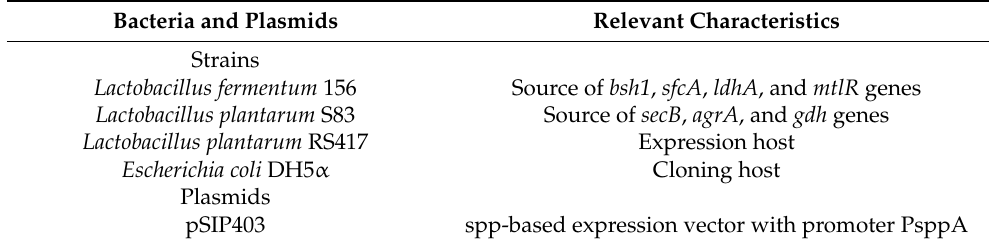
Table 1. Bacteria and plasmids used in this